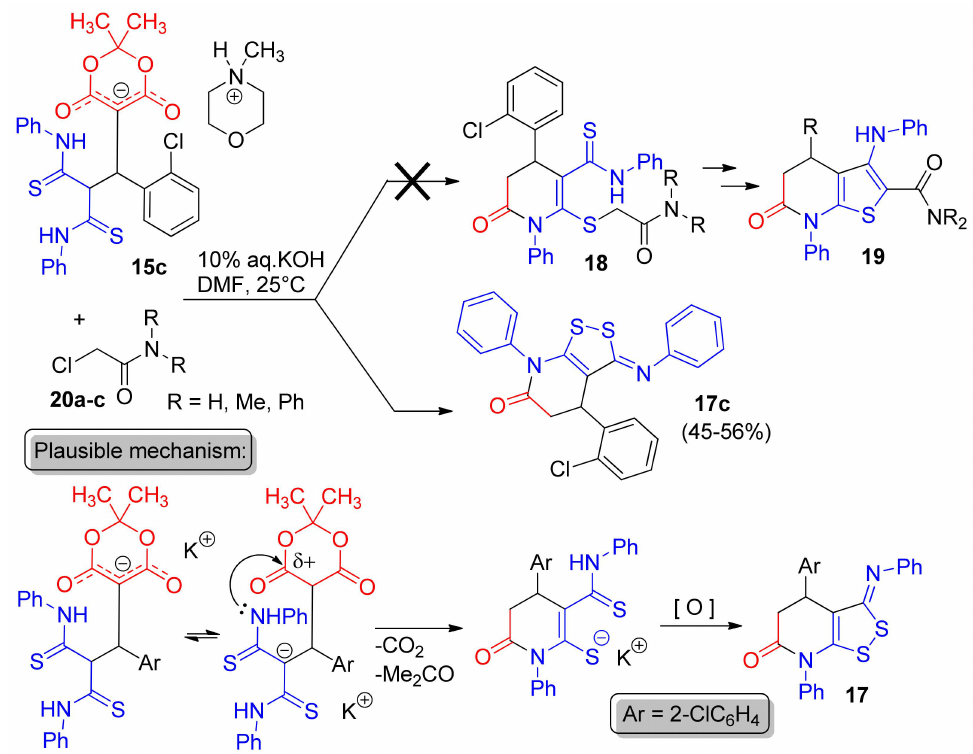
Scheme 5. Synthesis and plausible mechanism of formation of